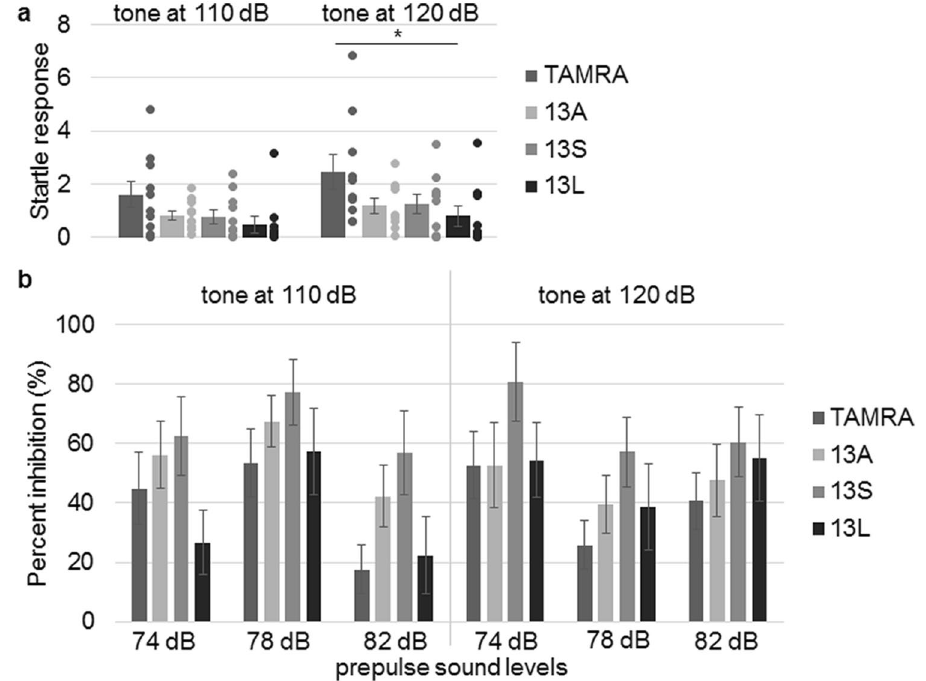
Figure 6. Injection of CM derived from 13L-treated BV2 microglia into lateral ventricle reduces startle response at 120 dB. Acoustic startle responses at 110 or 120 dB ( a ) and inhibition of the responses by prepulses (74, 78 or 82 dB) ( b ) in mice to which CM from BV2 microglia having TAMRA, 13A, 13S or 13L (n = 10 each, 5 males and 5 females) was injected. Error bars represent SE. ANOVA, *p <